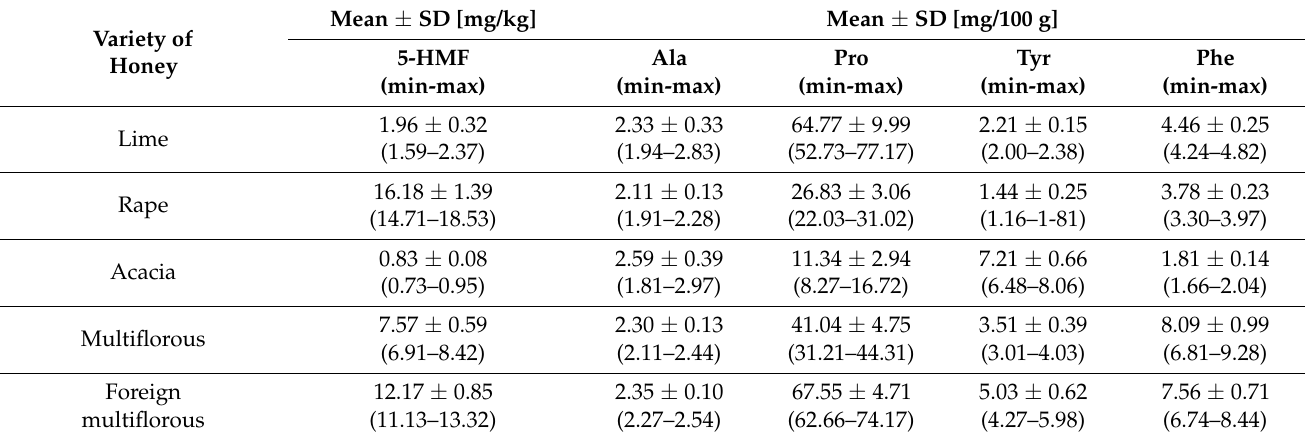
Table 2. Comparison of average amino acids and 5-HMF content in different varieties of